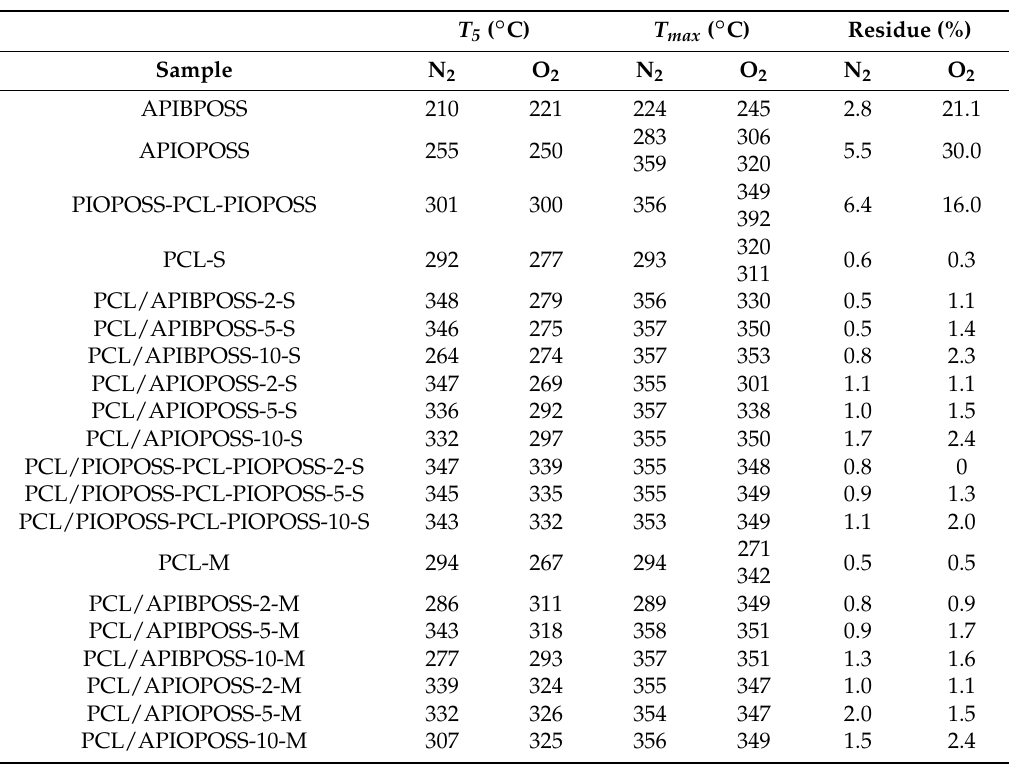
Table 2. Thermogravimetric analysis (TGA) data for PCL, PCL/APIBPOSS,